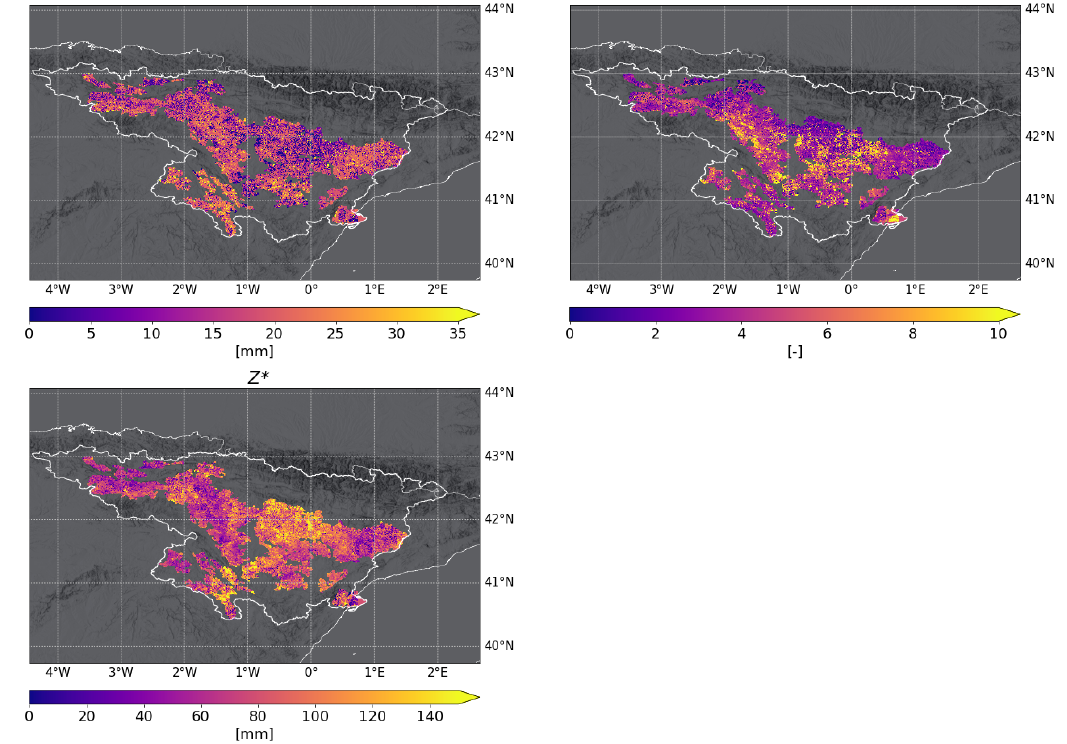
Figure A1. Spatial distribution of the calibrated values of the parameters a , b , and Z ∗ over the Ebro basin.